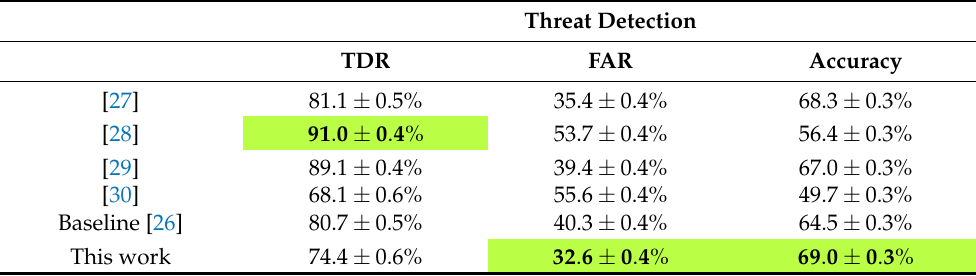
Table 9. Threat detection mode result comparison with previous works [26–30] with the best result in bold font. ‘TDR’ stands for threat detection rate and ‘FAR’ for false alarm rate. Green cells show values within the confidence interval for the best performance value (i.e., statistically non-significant